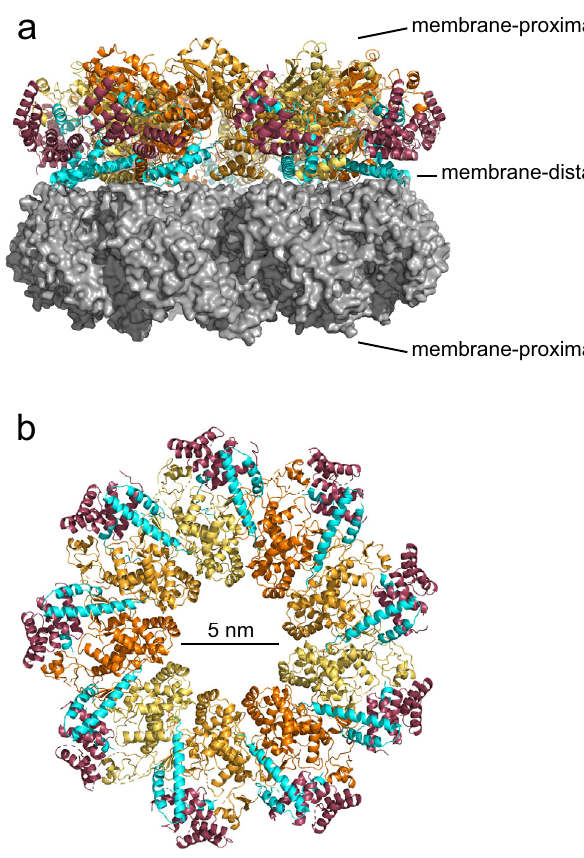
Fig. 3 Overall structure of the ternary YscV C :YscX 32 :YscY complex. a Side View of the two stacked nonameric rings of YscV c (orange, three shades for clarity). Half of the chains are shown as gray surface. YscX 32 (cyan) and YscY (red) bind on the periphery of the nonamer. b View on the membrane-distal side of one nonamer. The C-terminal helix of YscX protrudes into the ring between two adjacent YscV C